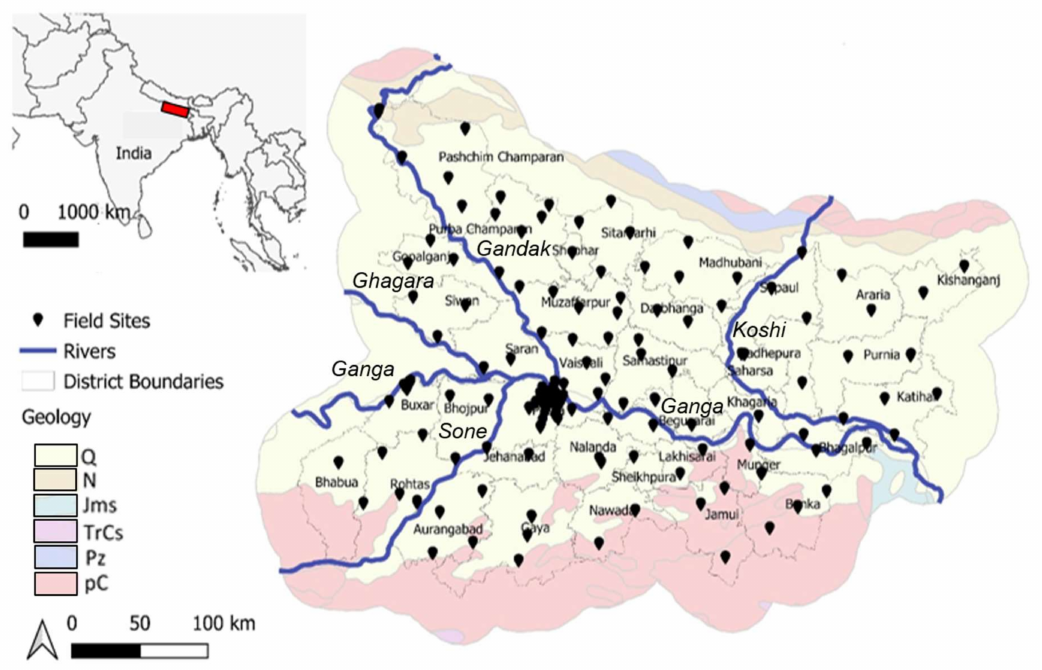
Figure 1. Groundwater sampling sites in Bihar, India [145] with major rivers labelled. Open-access layers are from Natural Earth [146], and geological layers from the US Department of Interior [147]. Geochronological categorization: Q = Quaternary; N = Neocene; Jms = Jurassic; TrCs = Triassic carboniferous; Pz = Paleozoic; pC = Pre-Cambrian. Area of detailed site map corresponds approximately to red box on regional